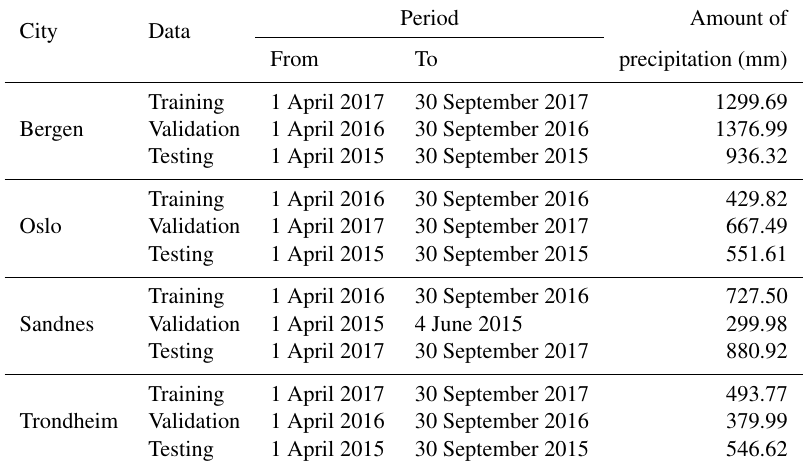
Table 2. Periods selected for model training, validation and testing. Period Amount of City Data From To precipitation (mm) Training Bergen